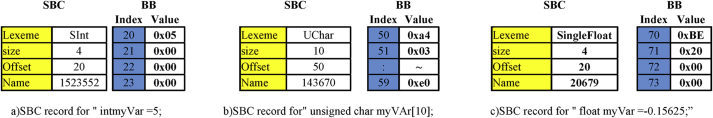
SBC Data representation examples.